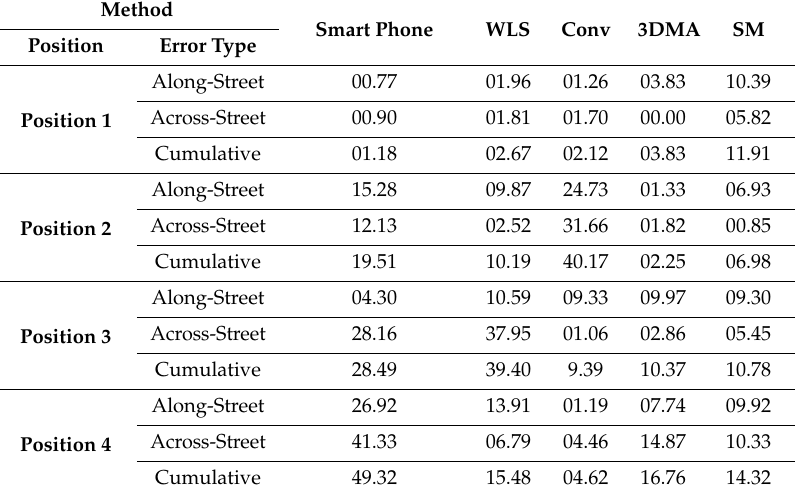
Table 4. Performance comparison of positioning results for di ff erent methods. Unit: